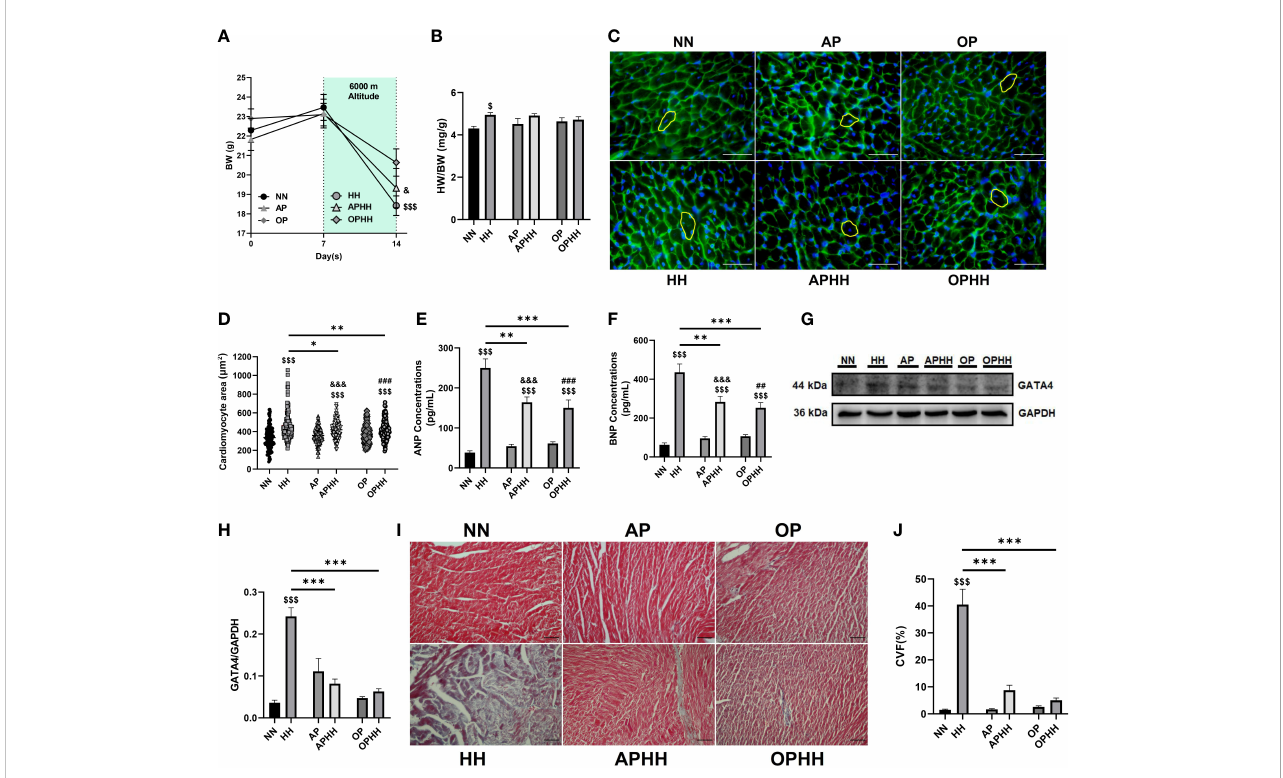
FIGURE 2 OP mitigates myocardial hypertrophy, injury, and fi brosis during hypobaric hypoxia. (A) Graphical representation of Body Weight (BW) trends of 14 days period by Normobaric Normoxia (NN), Hypobaric Hypoxia (HH), Altitude Preconditioned (AP), Altitude Preconditioned before HH exposure (APHH), Occlusion Preconditioned (OP) and Occlusion Preconditioned before HH exposure (OPHH) mice (n= 7-15 mice per experimental group). (B) Graphical presentation of Heart Weight (HW)/BW ratio (n= 5-10 mice per experimental group). (C-H) Indexes for cardiac hypertrophy assessment, including; Representative Wheat germ agglutinin (WGA) staining and Graphical presentation of Cardiomyocyte surface area (n=8-12 cells per section per 4-6 heart per group), Atrial natriuretic peptide (ANP) and Brain natriuretic peptide (BNP) concentrations (n=6-8 hearts per group), Representative Immunoblotting of GATA4 and its Graph plot (n= 3 hearts per group). ELISA were performed in triplicates. Immunoblots were performed in triplicates, and each blot band in the representative blot is an independent biological sample. (I, J) Representative Masson ’ s trichome staining and Graphical presentation of collagen volume fraction (CVF) showing the extent of fi brosis among experimental groups (n= 3-6 sections per 4,5 hearts per group). $ p<0.05, $$$ p<0.001 HH vs NN; & p<0.05, &&& p<0.001 APHH vs AP; ## p<0.01, ### p<0.001 OPHH vs OP; * p<0.05, ** p<0.01, *** p<0.001. Data are expressed as mean ± SEM. Data were analyzed using one-way anova, followed by Tukey ’ s post hoc